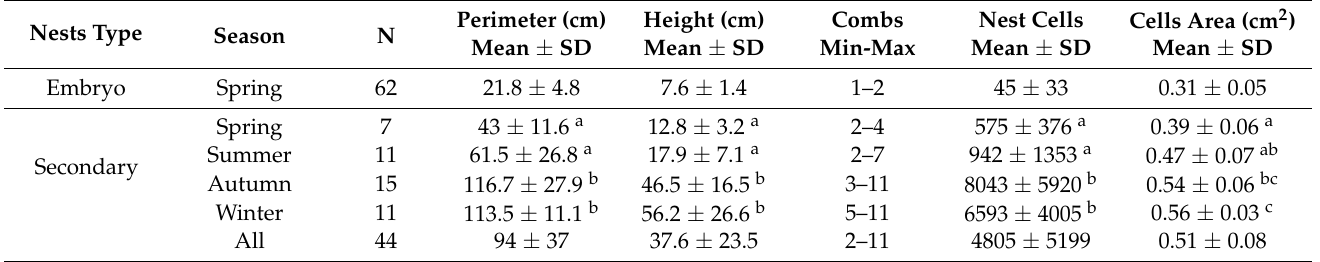
Table 1. Mean ± standard deviation (SD) of structural characteristics of the different types of nests (embryo and secondary) were classified by season in which they were removed.